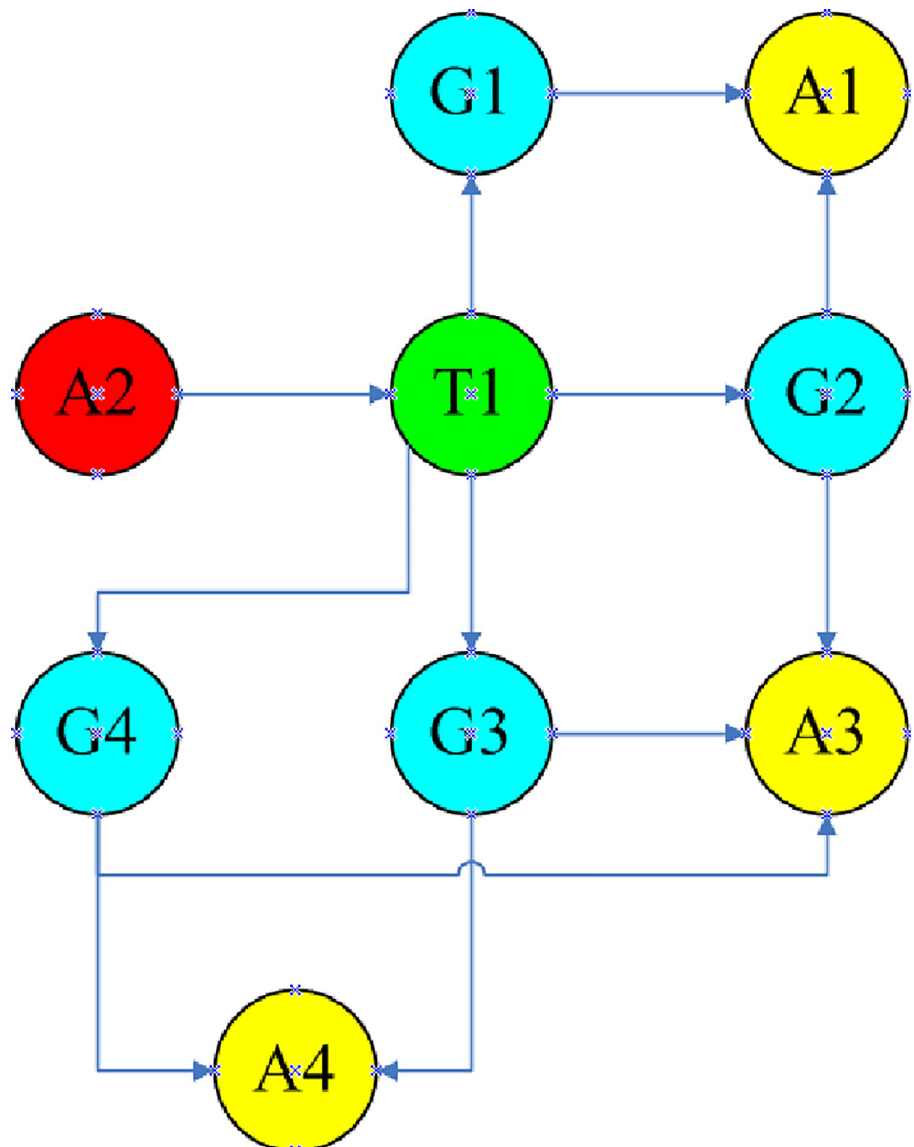
Fig 9. The propagation path of the case study (primary scenario in red, the second level scenario in green, the third level scenario in blue and the fourth level scenario in yellow) [58].